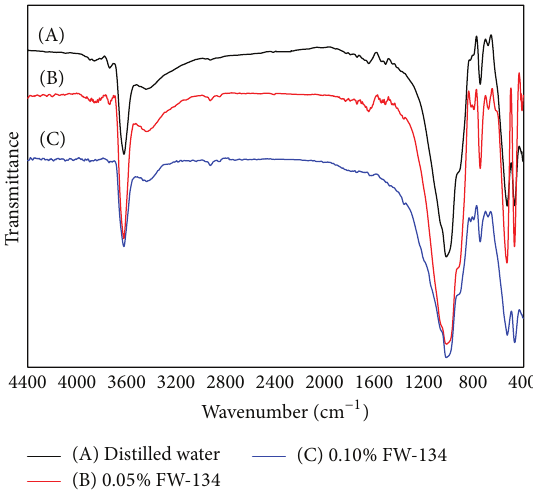
Figure 2: FT-IR spectra of samples adsorbing FW-134.